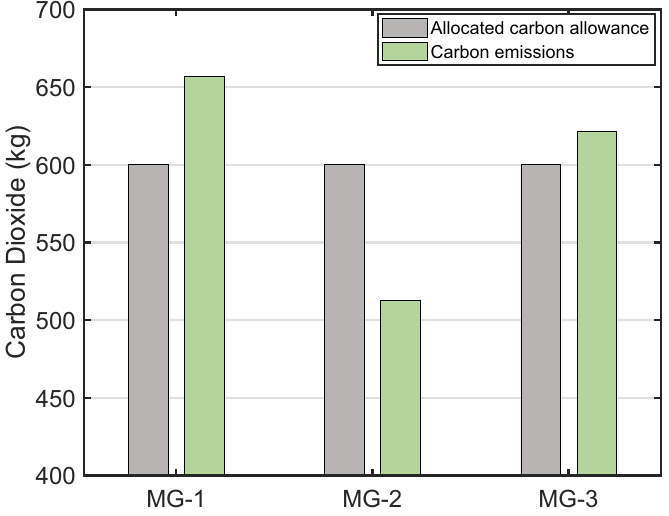
Figure 9. The allocated carbon allowance and carbon emissions of